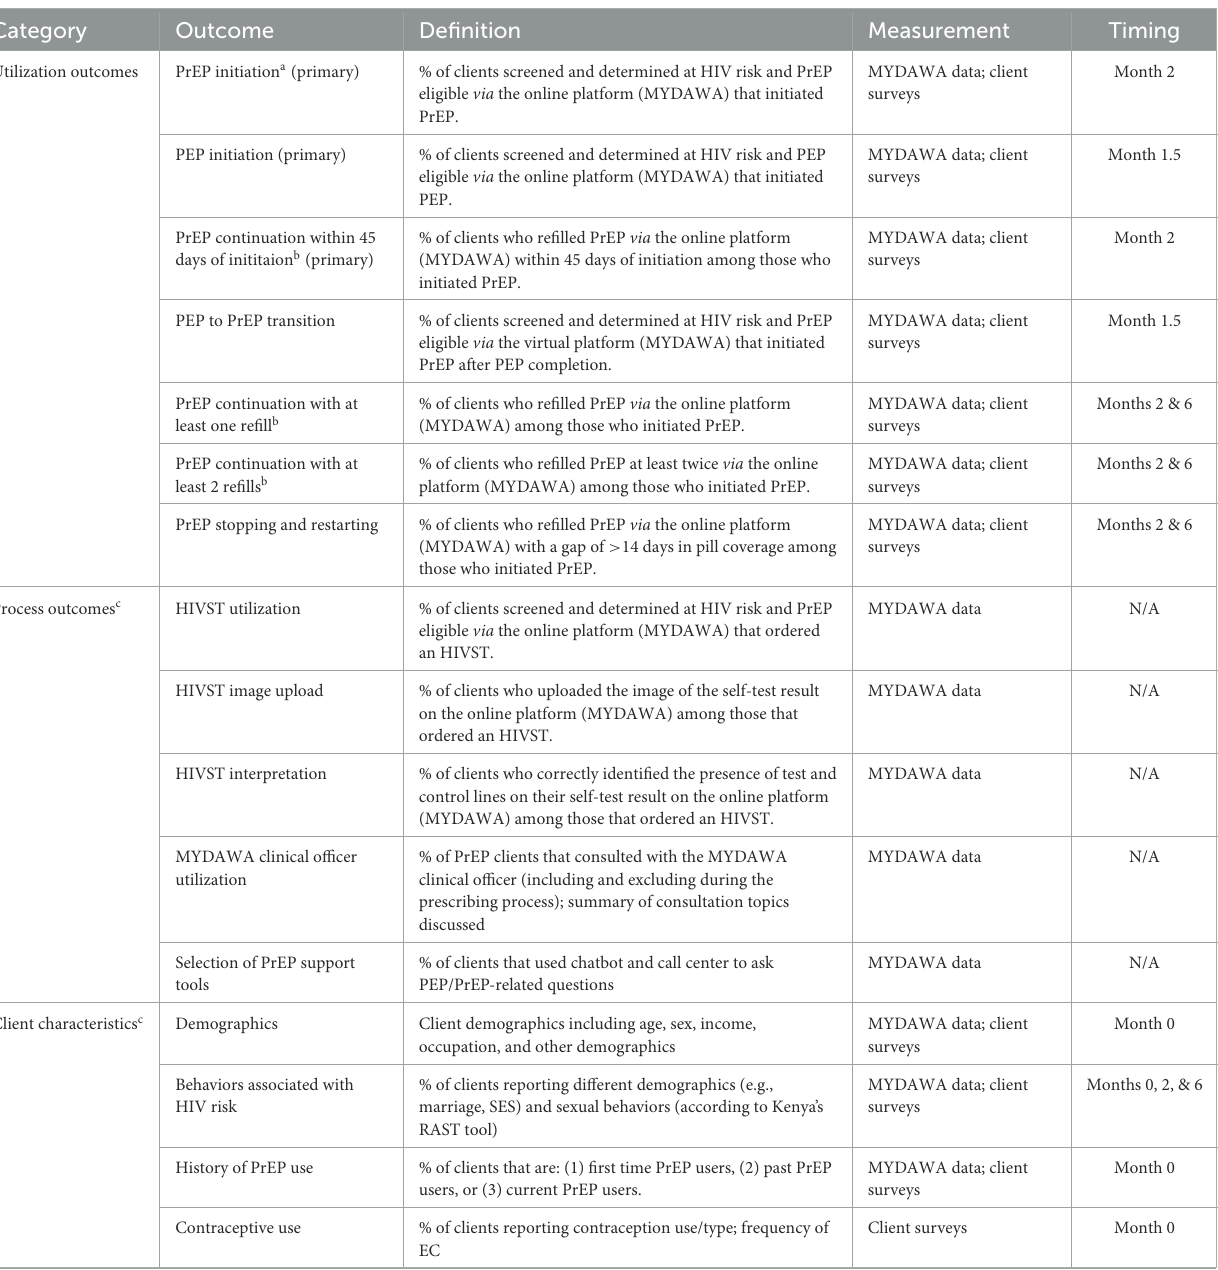
TABLE 1 The utilization outcomes, process outcomes, and client characteristics measured in the pilot